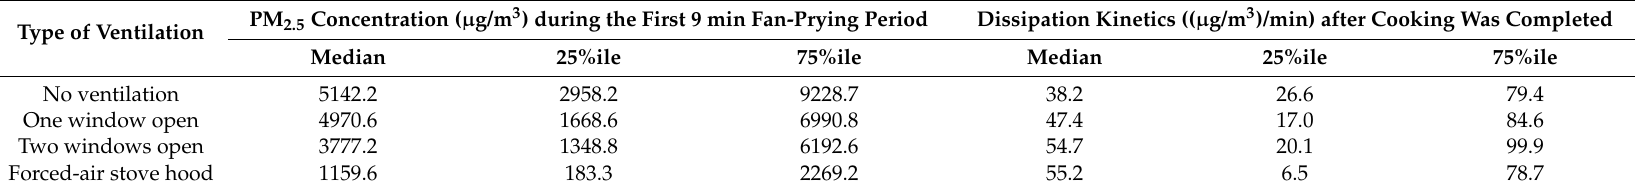
Table 3. Distributions of indoor PM 2.5 concentrations during the first 9 min of cooking period and the dissipation kinetics after cooking was completed. Type of